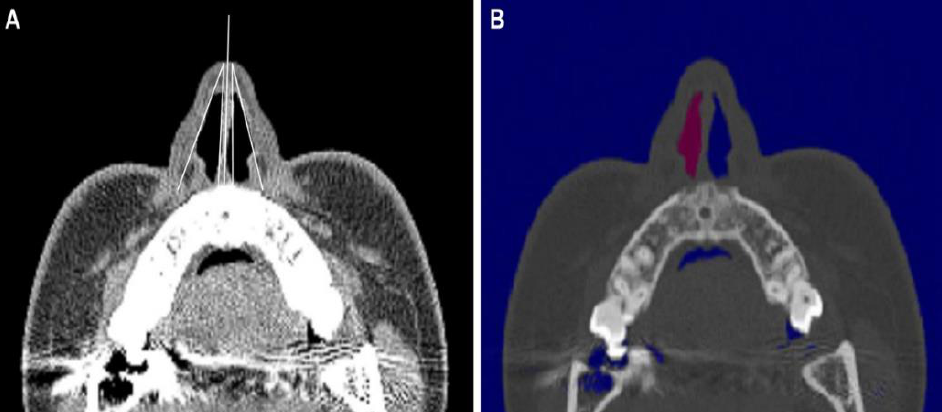
Figure 2. ( A ) Measurements of the INV obtained via computed tomography (CT). The angle of the INV was measured by averaging the irregularities in the medial and lateral walls. ( B ) Measurements of the cross-sectional area (CSA) via CT. The nasal valve area was measured in images taken per- pendicular to the acoustic axis.